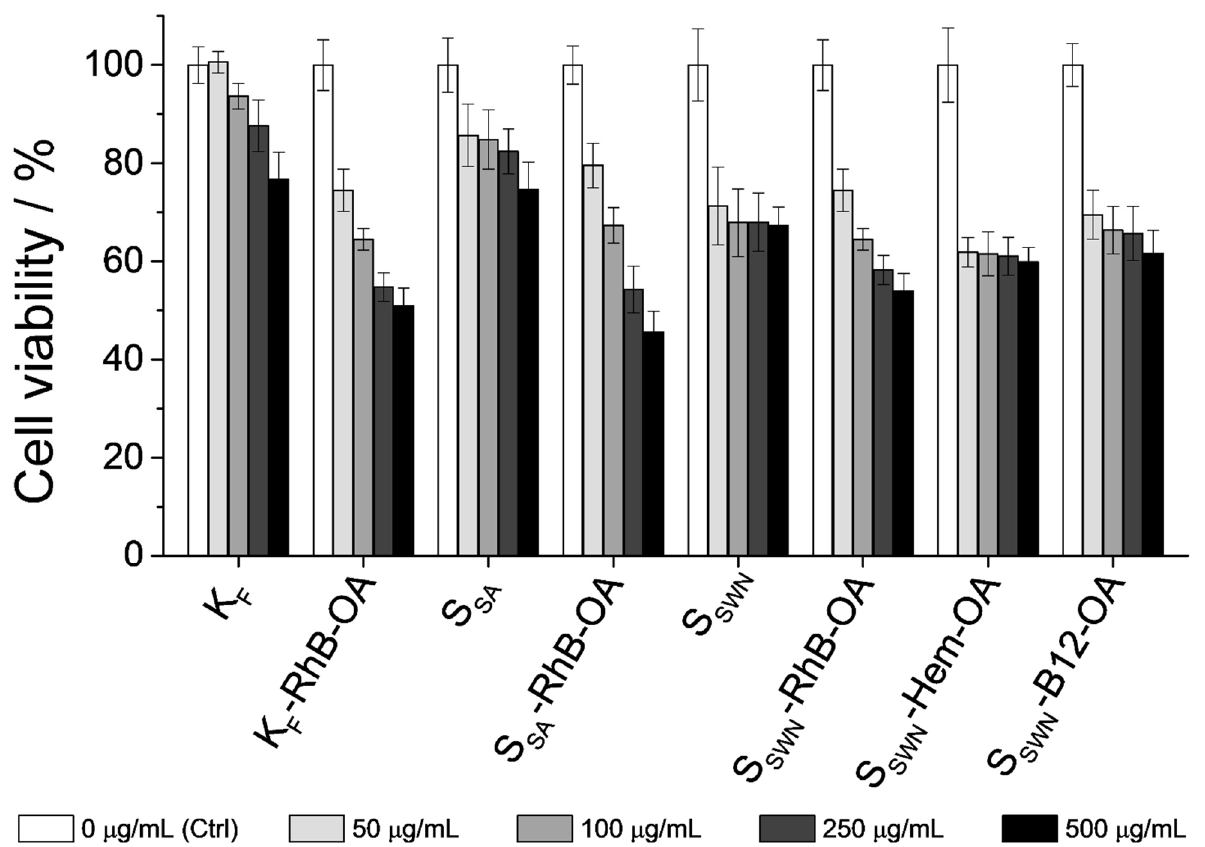
Figure 8. MTT cell viability assay of Caco-2 cells exposed to the indicated materials. Caco-2 cells were treated with the bare clays and the gated organonanoclays at concentrations of 0 (control), 50, 100, 250 and 500 μ g/mL (increasing from light grey to black) for 24 h. Cell viability was quantified by means of DMSO solubilization of the MTT-metabolization crystals.